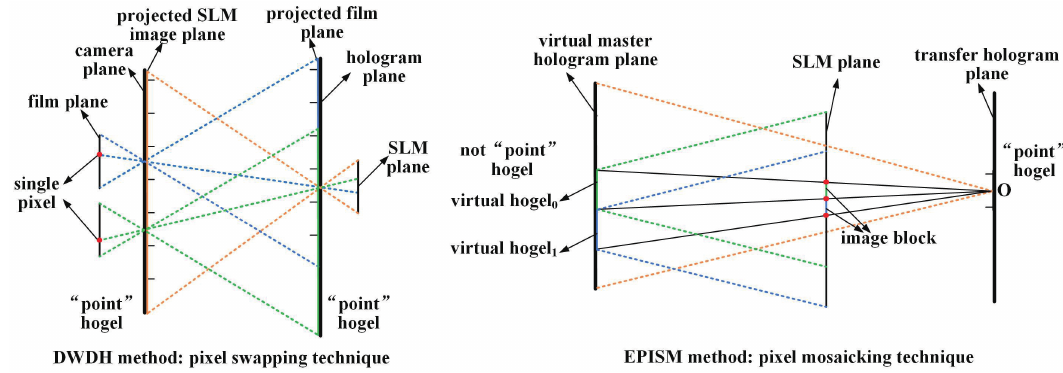
Figure 8. Differences between the DWDH method and the EPISM method.